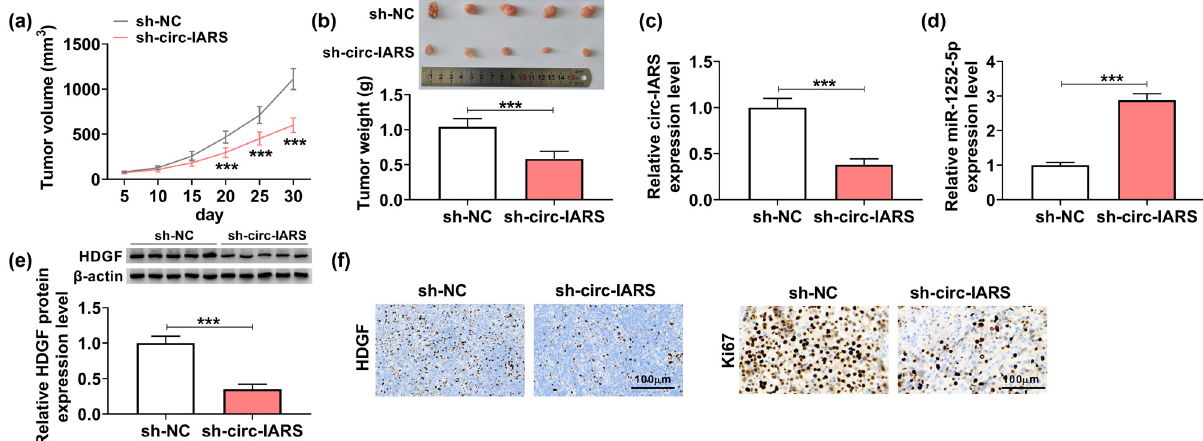
Figure 6: Silencing circ - IARS retarded the tumor growth of NSCLC in vivo . ( a ) Tumor volume was monitored every 5 days after inoculation of sh - circ - IARS or sh - NC - transfected H1299 cells into nude mice ( N = 5 ) . ( b ) Tumor weight was examined at the end day of the xenograft experiment. ( c and d ) RT - qPCR detected the relative circ - IARS and miR - 1252 - 5p expression, and ( e ) western blotting measured the relative HDGF protein expression in tumor tissues from nude mice. ( f ) IHC examined the HDGF and Ki67 expression in para ffi n - embedded xenograft tumor tissues. *** P < 0.001.